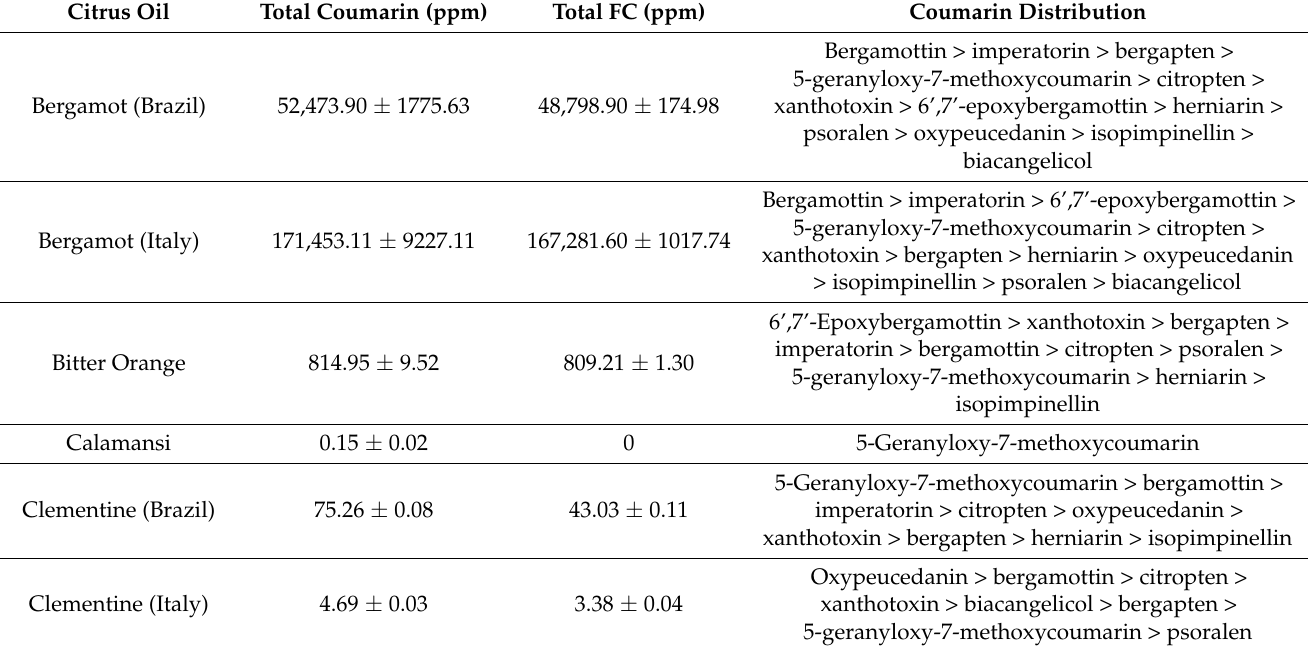
Table 2. Total coumarin, total furanocoumarins, and coumarin distribution of the tested Citrus oils. Citrus